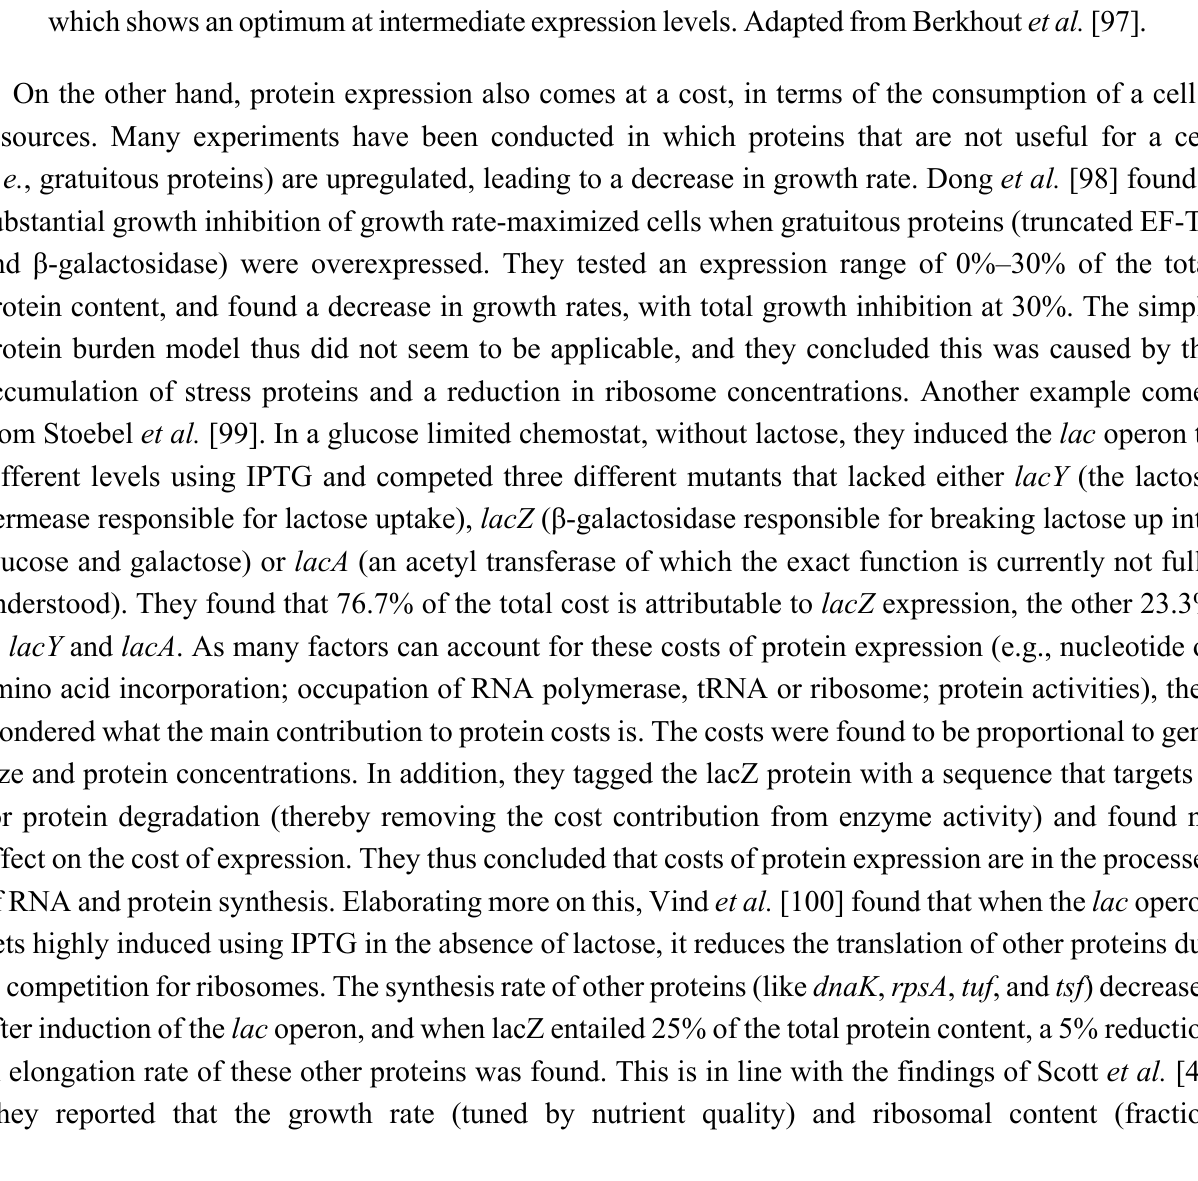
Figure 8. The costs (in blue) at increasing protein expression levels increase linearly, while benefits (in orange) will go towards a maximum. This leads to a fitness curve (in black) which shows an optimum at intermediate expression levels. Adapted from Berkhout et al.